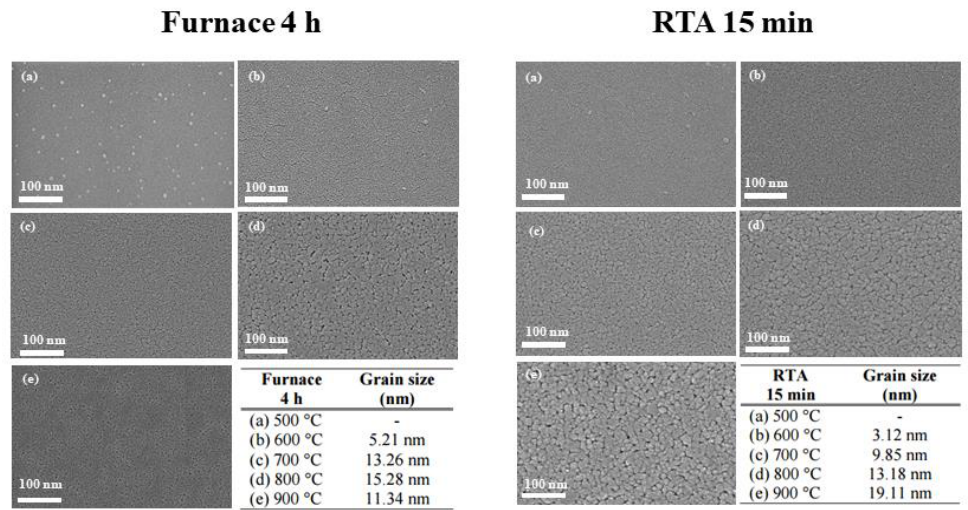
Figure 6. FE- SEM images of β -Ga 2 O 3 thin films prepared via furnace and RTA processes: ( a ) — 500 °C, ( b ) — 600 °C, ( c ) — 700 °C, ( d ) — 800 °C, and ( e ) — 900 °C using different annealing methods: furnace 4 h and RTA (non-furnace). Magnification: 200.00 K X; Acceleration voltage: 5.00 kV; Working distance: 4.8 mm. Image resolution pixel: 1024 × 768 pixel.